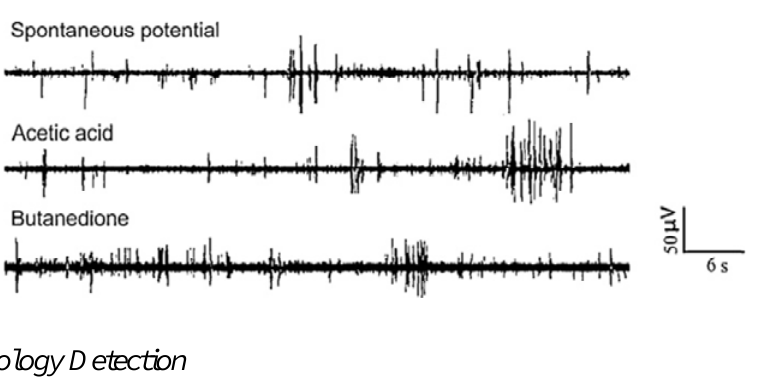
Figure 14. Electrophysiological signal changes of olfactory cells after stimulation of acetic acid and butanedione. (Reprinted from [75]. © 2010, with permission from